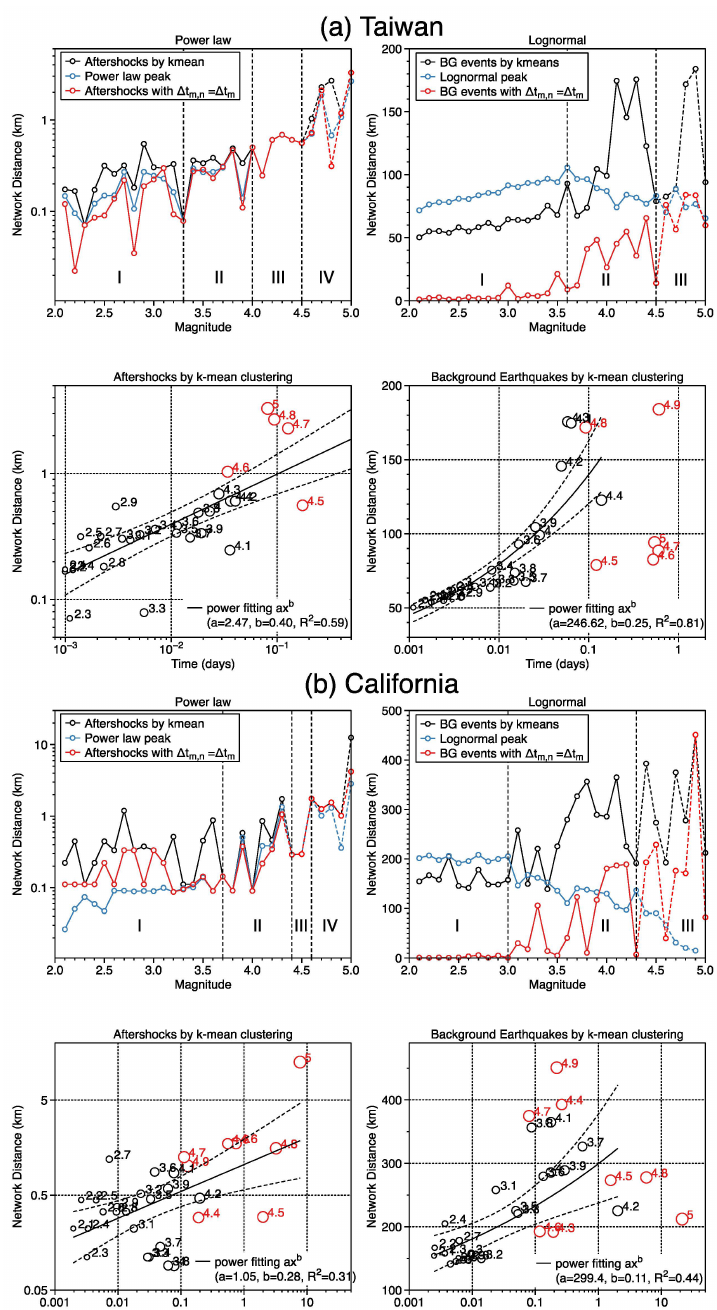
Figure 6. The spatiotemporal relation of aftershocks and background earthquakes in ( a ) Taiwan and ( b ) California. The left and right panels show the results using aftershocks and background earthquakes categorized by k-means, respectively. The top and bottom panels show the relationships of the network distance with magnitude and time, respectively. In the relationships of the network distance with magnitude (top panels), the modes of the network distances for different time windows and magnitudes are calculated; the red curves show that the time window equals to the average interevent time and the black curves show the mean of the modes. The blue curves show the network distance at the highest frequency of the fitted power law distribution and the lognormal distribution. In the relationships of the network distance with time (bottom panels), the network distances are the same as the black curves, and the time is the mode of the mean of interevent time. The black and red circles show the results for the events with magnitudes smaller and larger than the characteristic magnitude,